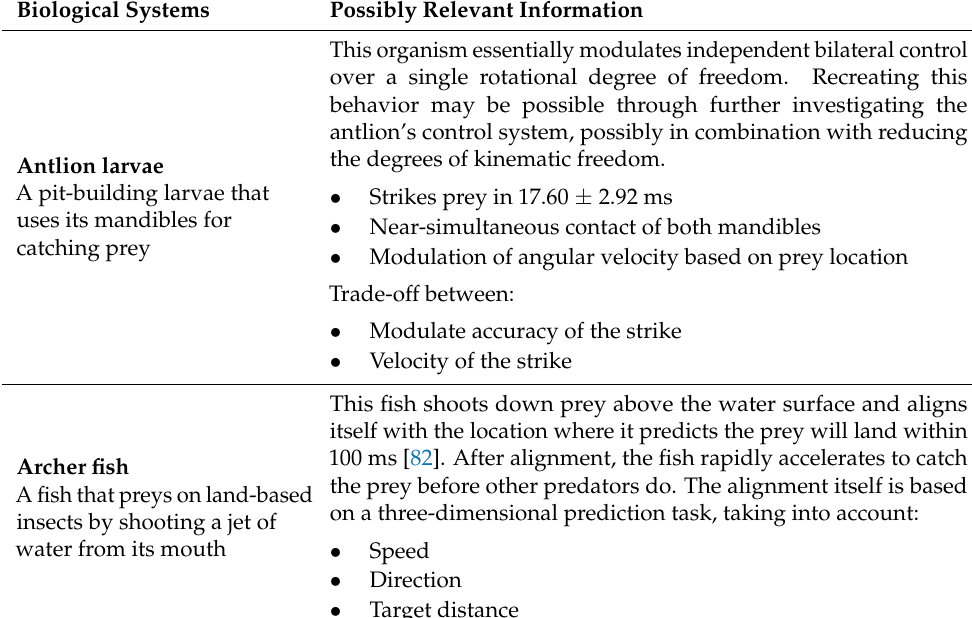
Table 6. Overview of two possibly relevant biological systems within the solution space of a speed-accuracy trade-off. The information listed as possibly relevant has been manually extracted from the information sources by quickly scanning through the documents. Adapted from Lambert et al. [81], and Rossel et al.